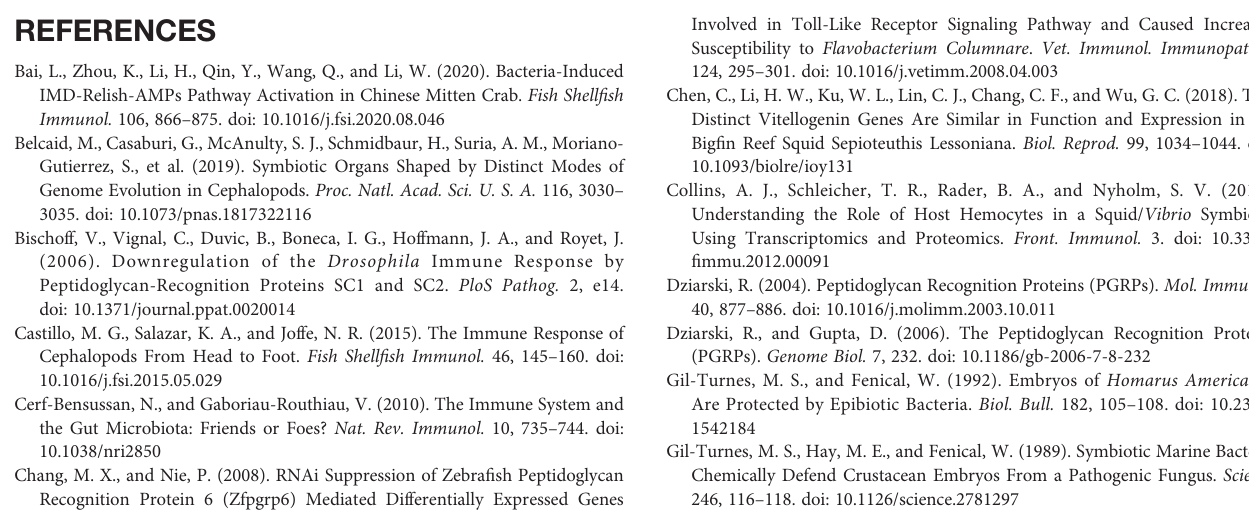
Supplementary Table 1 | The characteristics of sampled female squids. Supplementary Table 2 | List of gene names and accession numbers for phylogenetic